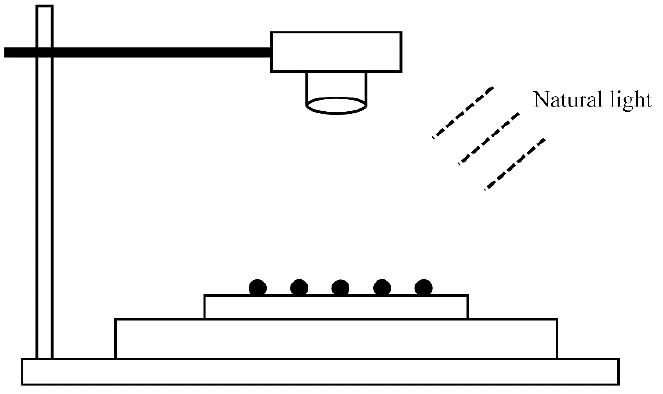
Figure 1. Image of maize seed varieties.